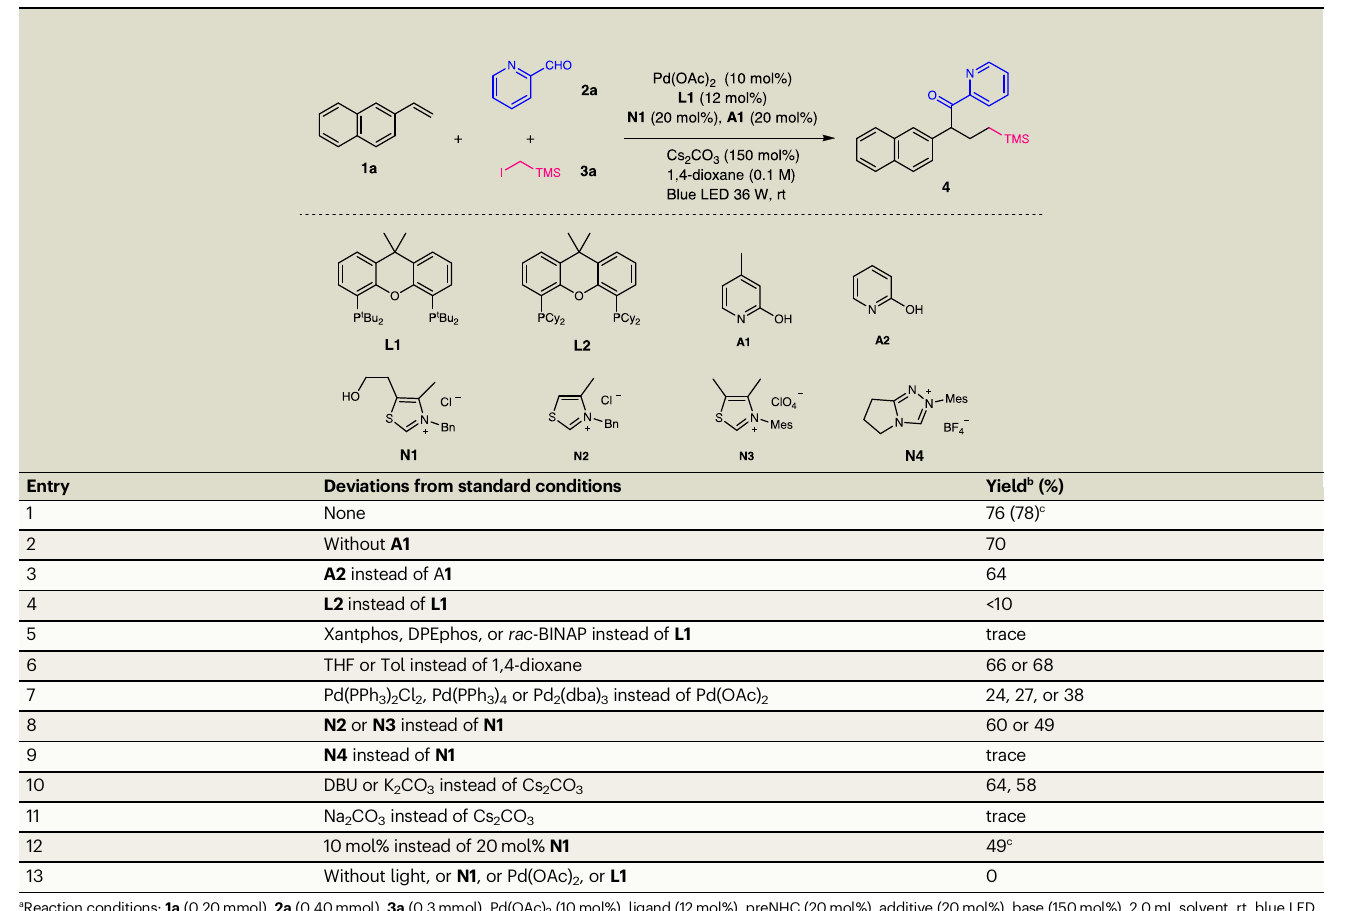
Table 1 | Condition optimization